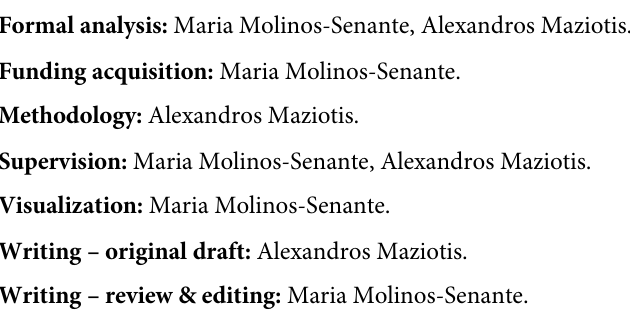
S1 Table. Estimated results from firm-specific